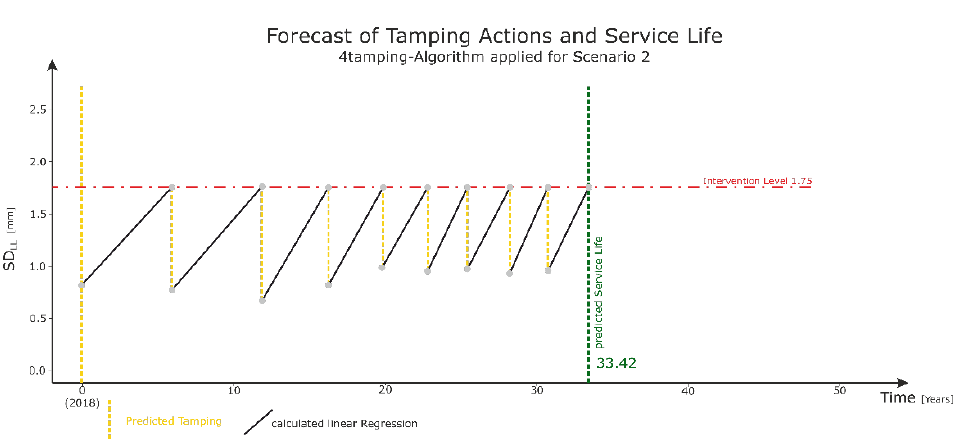
Figure 7. Showing the predicted through-going Tamping Actions and Service Life for the Track Section according to Scenario 1 based on the 4tamping-Algorithm.